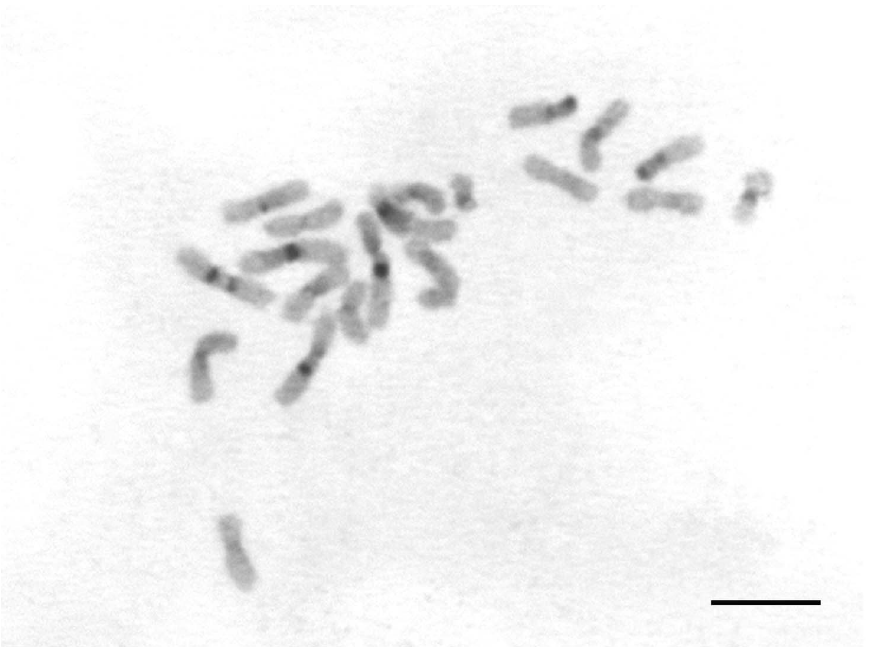
Figure 2. C-banding in the worker metaphase of Acromyrmexstriatus . The dark-grey regions denote chromosome pairs containing obvious heterochromatin blocks. Scale bar=5 m m. doi:10.1371/journal.pone.0059784.g002 PLOS ONE |